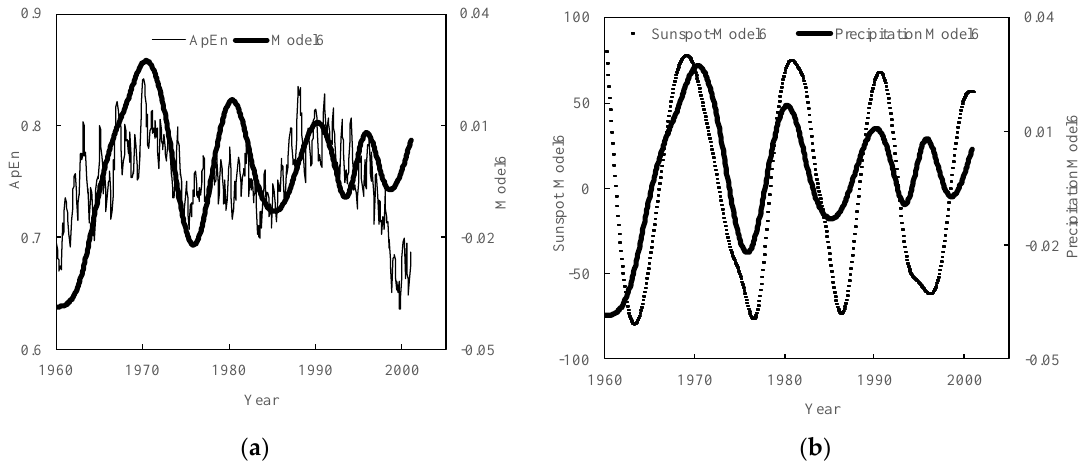
Figure 10. The comparisons between the precipitation ApEn and IMF-6component ( a ) as well as between the IMF-6 component of sunspot numbers and IMF-6 component of precipitation ( b ).